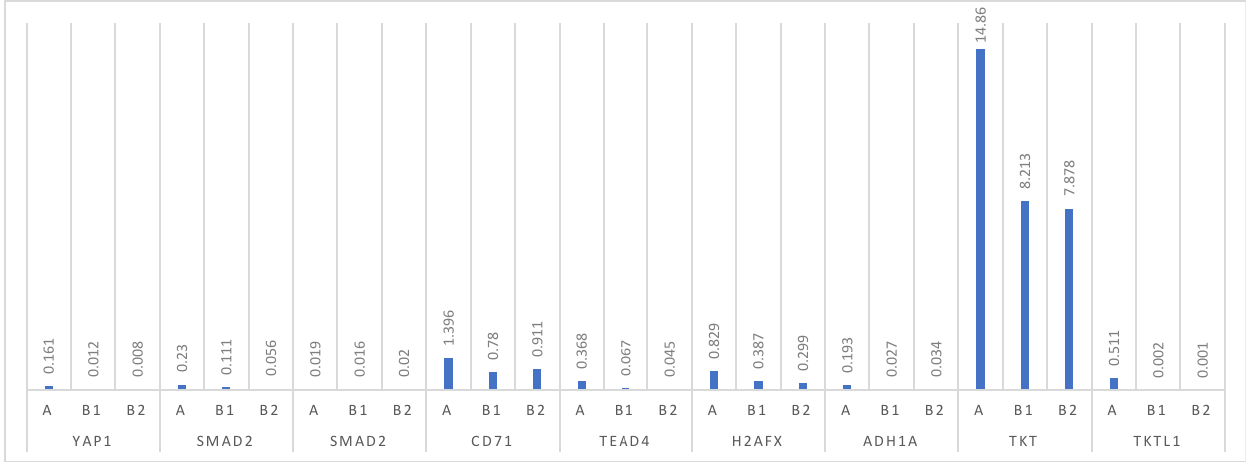
Figure 1. The expression distribution of the tested proteins.